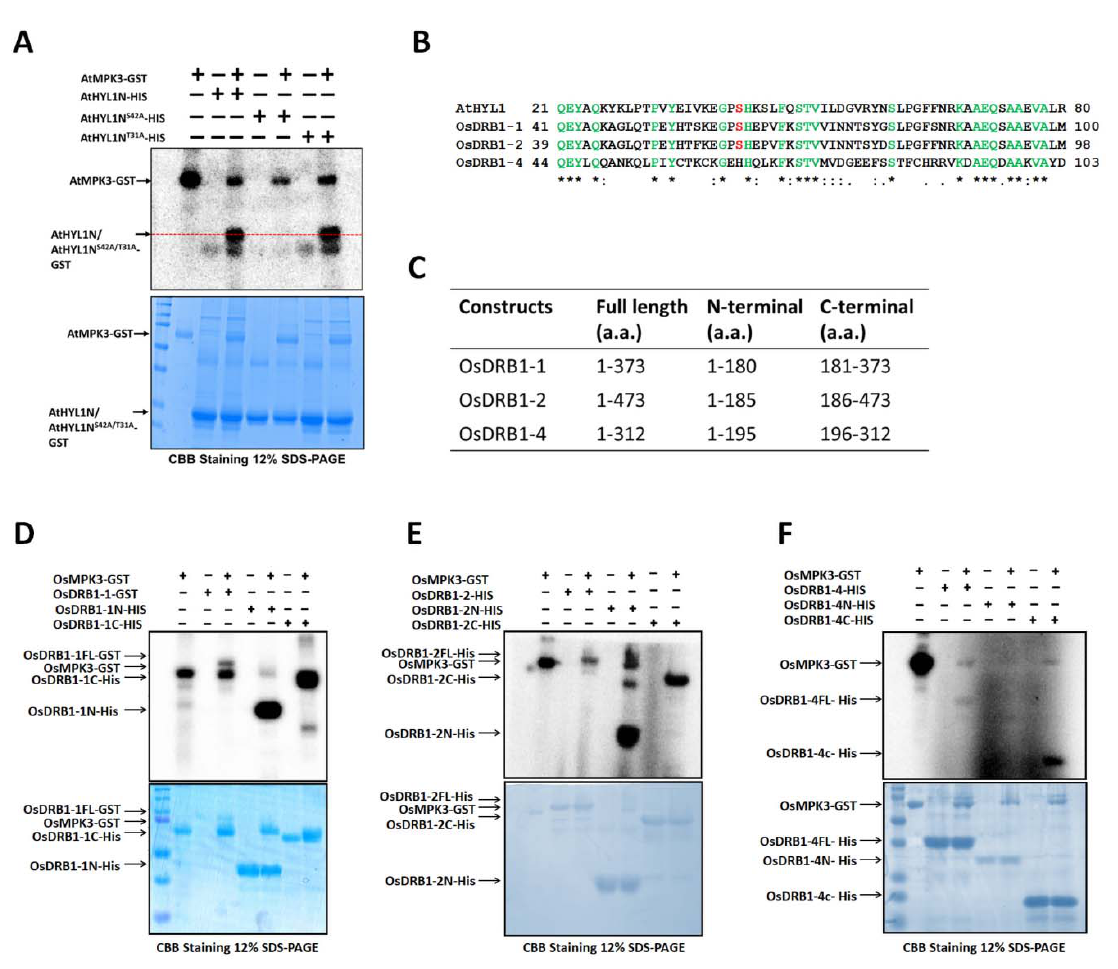
Figure 2. AtMPK3 phosphorylates AtHYL1 at the serine-42 residue at the N-terminal domain. ( A ) The in vitro phosphorylation of wild type and phosphor-null AtHYL1N by AtMPK3. Two putative MAPK phosphorylation sites on AtHYL1 (threonine-31 and serine-42) were mutated individually to alanine (AtHYL1N T31A and AtHYL1N S42A ) and wild type AtHYL1N was incubated with AtMPK3 in a kinase buffer. +, − signs indicate presence and absence of respective proteins. ( B ) The amino acid alignments of AtHYL1 and OsDRBs showing the conserved serine residue marked with a red box, which is absent in OsDRB1-4. (*, **, ****) represents conserved amino acids. ( C ) The amino acid length of N and C-terminals of OsDRBs used for protein expression. An in vitro phosphorylation assay showing the phosphorylation of full-length and truncated proteins of OsDRB1-1 ( D ), OsDRB1-2 ( E ), and OsDRB1-4 ( F ) by OsMPK3. The upper images are the autoradiographs and the lower are CBB stainings of the respective